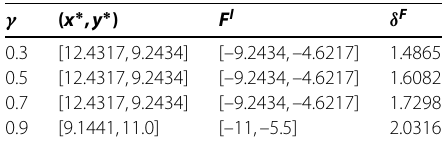
Table 4 Objection function values and corresponding preference-based indices under different optimism degrees of Example 3